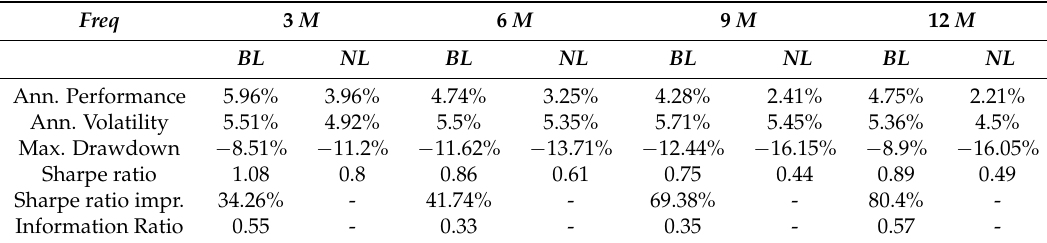
Table 6. Statistics for BL and NL strategies with different levels of the review frequency Freq . The Sharpe ratio improvement is calculated as the relative difference between BL and NL Sharpe ratios for the same review